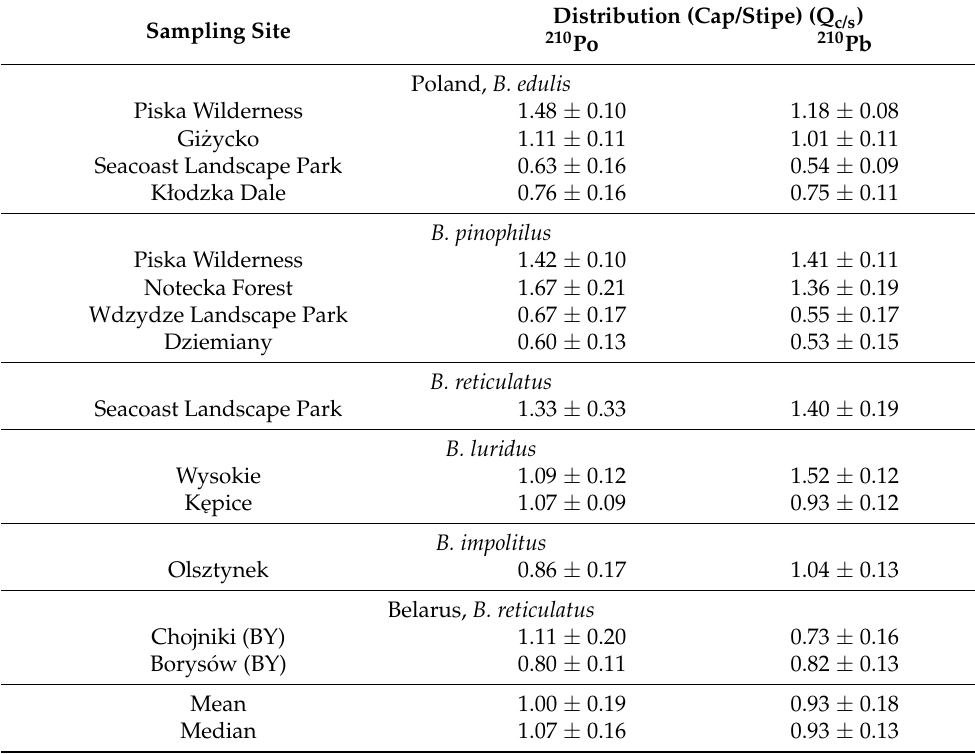
Table 2. Average values of the Q c/s distribution for 210 Po and 210 Pb in boletes.